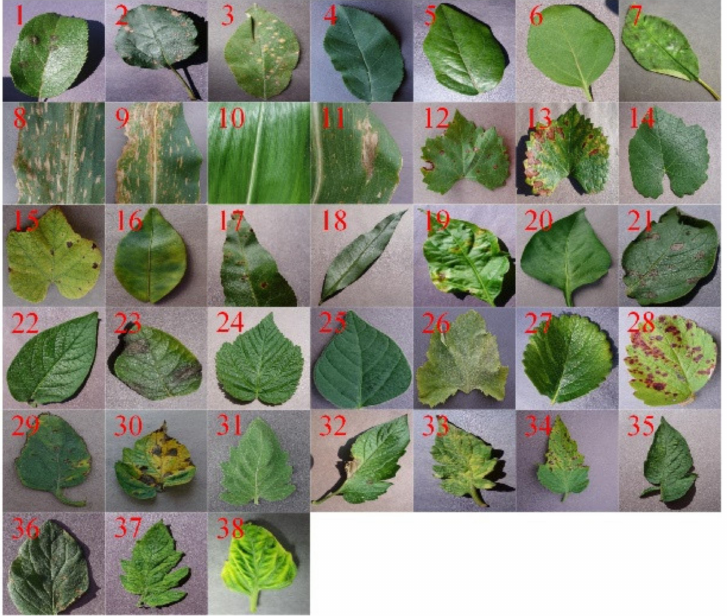
Figure 1. Leaf disease images with simple background in Plant Village.